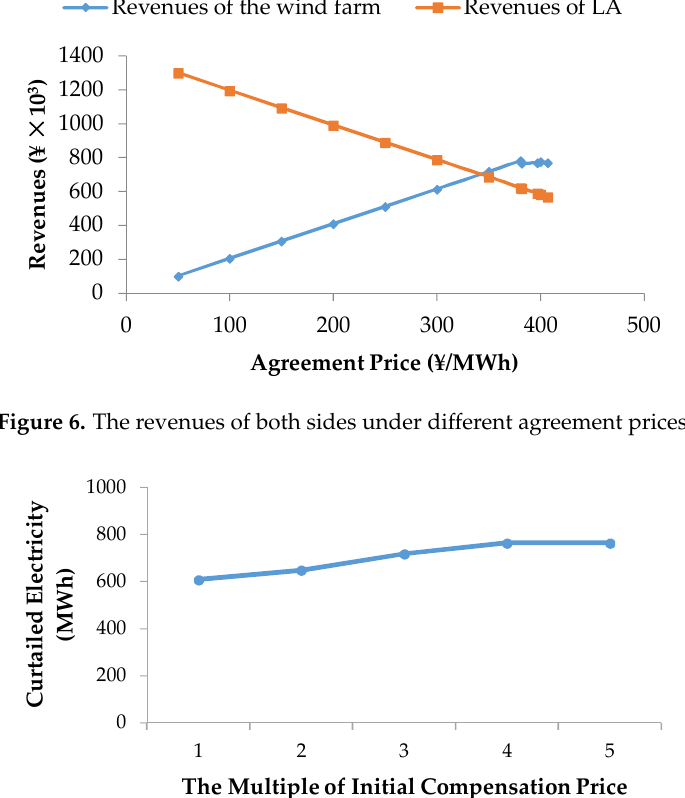
Figure 7. Wind curtailment under different compensation prices.